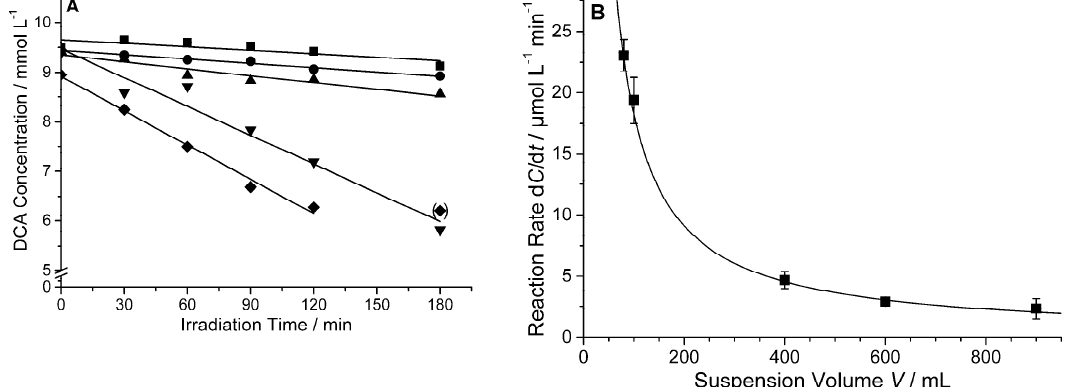
Figure 3. Photocatalytic degradation of dichloroacetic acid (DCA) varying the suspension volume: ( A ) Concentration vs. time profiles obtained with 900 ( ■ ), 600 ( ● ), 400 ( ▲ ), 100 ( ▼ ), and 80 mL ( ♦ ) suspension; ( B ) Reaction rates d C /d t (calculated from the slopes of the plots in (A)) vs. the suspension volume V . The line in ( B ) was calculated with d C /d t = k / V and k = 1.82 µmol min − ¹. Experimental conditions: Hombikat UV 100, γ = 5 g L − ¹, C s = 10 mmol L − ¹, photon flux = 10.7 µmol min − ¹, pH 3, 10 mmol L − ¹ KNO 3 , air saturated, ambient temperature.